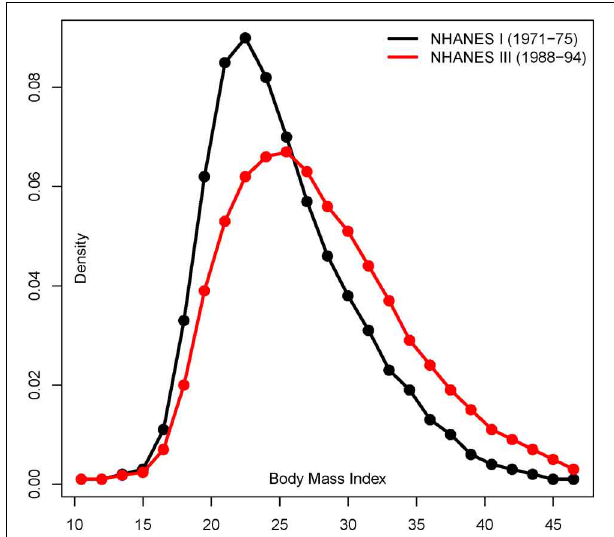
FIGURE 3 | Shift in BMI in U.S males from 1971–1975 to 1988–1994. Distribution of BMI in North American males (20–55 age) studied in the NHANES I and III health and nutritional surveys (adapted from Figure 1 in Cutler et al., 2003).